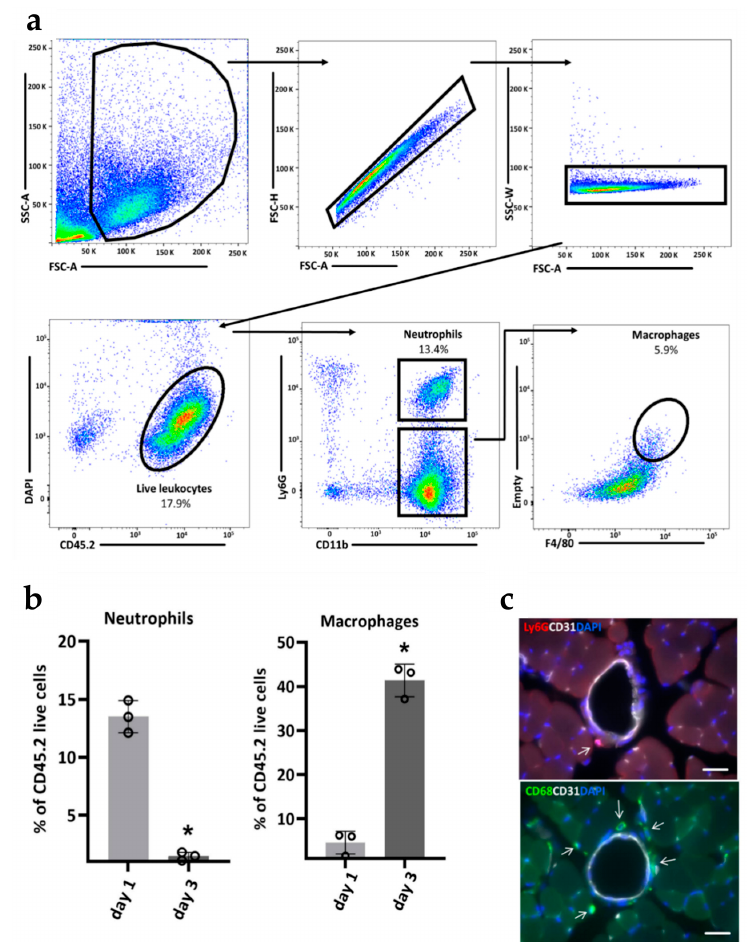
Figure 2. Gating strategy of flow cytometry and immunohistological analyses. ( a ) Sequential gating strategy for the identification of neutrophils (CD45.2 + CD11b + Ly6G + ) and macrophages (CD45.2 + CD11b + F4 / 80 + ) in the murine adductor muscle containing growing collateral arteries at day 1 after FAL. ( b ) Bar graphs showing the frequencies of neutrophils and macrophages at day 1 and day 3 after FAL. n = 3 mice/group, data are represented as mean ± S.E.M, * p < 0.05 from unpaired student’s t-test. ( c ) Representative immunohistochemical stains demonstrate the presence of neutrophils (Ly6G + ) and macrophages (CD68 + ) (indicated by arrows) in the perivascular space of growing collaterals in the adductor muscle of a mouse 3 days after FAL. Collaterals were stained with an endothelial marker (CD31) and nuclei with DAPI. Scale bar 20 µ m.